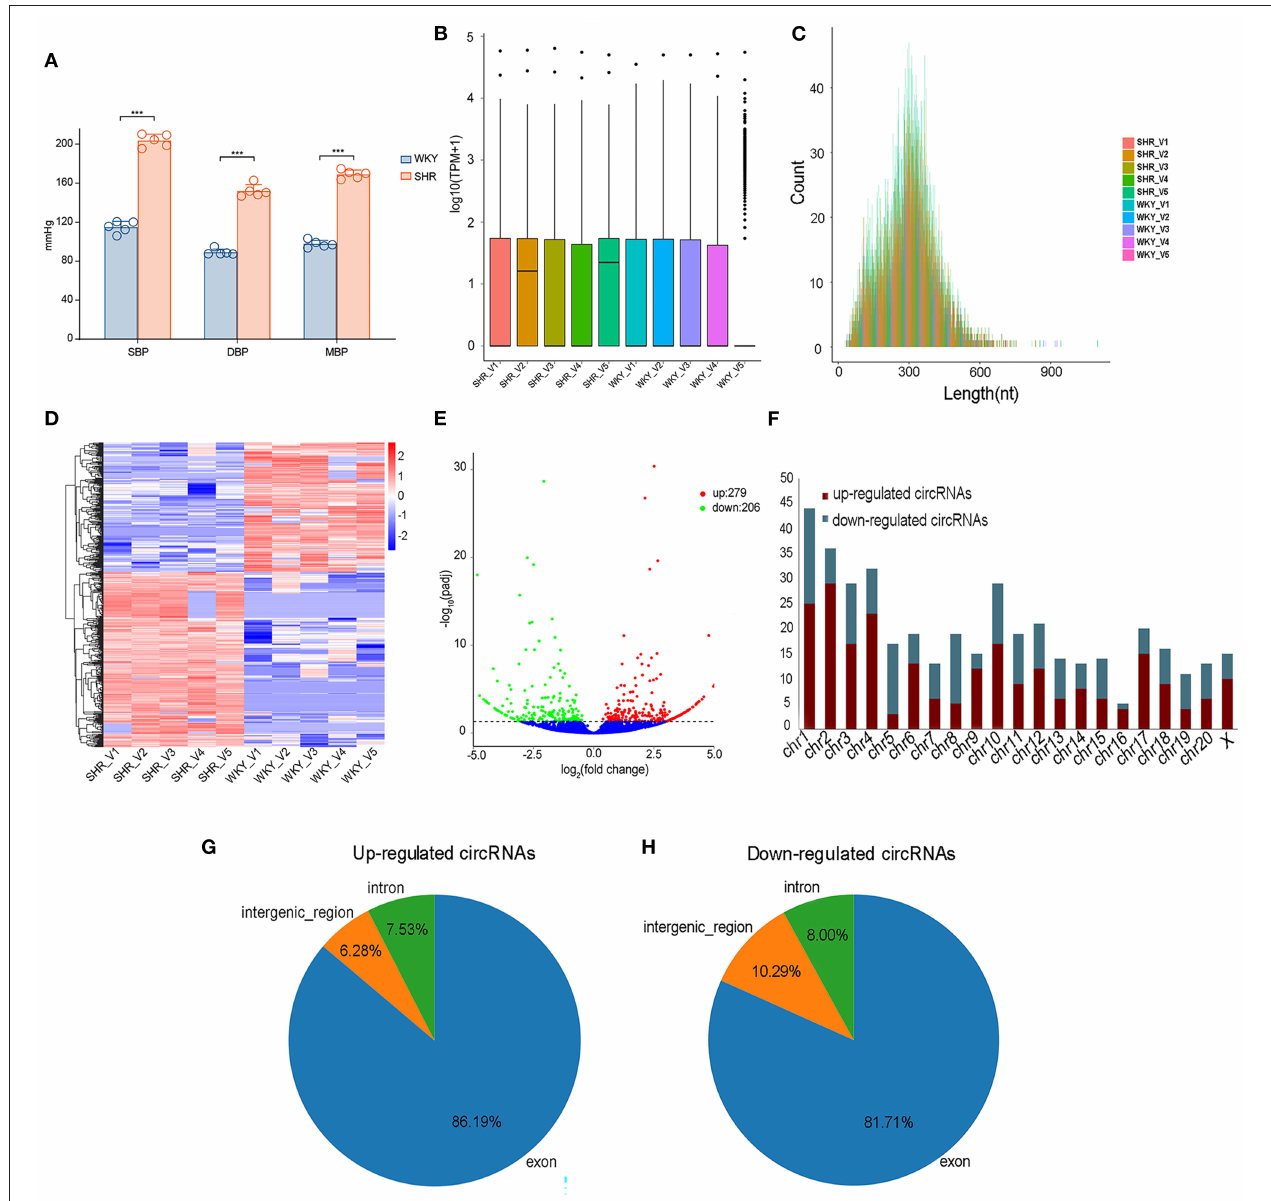
FIGURE 1 | The expression profiling of vascular circRNAs was screened and analyzed by RNA-seq of aortic vascular tissues between SHR and WKY rats. (A) Compared with WKY controls, SBP levels, DBP levels and MBP levels were significantly elevated in SHR rats. (B) The data standardization of the total expression of the circRNAs. (C) The length of circRNA profiles. (D) The hierarchical cluster analysis was performed with the significantly different circRNA expression profiles in SHR and WKY aorta (Fold Change > 2 and P < 0.05); Red and blue denoted high and low relative expression, respectively, each circRNA was expressed by a single row of colored boxes and each sample was represented by a single column. (E) Volcano plot showed that the differential expression analysis of circRNAs (red, up-regulated; green, down-regulated). (F) The distribution of chromosomes of upregulated and downregulated circRNAs, respectively. (G,H) The identification of exon, intron and intergenic region of upregulated and downregulated circRNAs. RNA-seq, high-throughput RNA sequencing; WKY, Wistar-Kyoto; SHR spontaneously hypertensive rat; SBP, systolic blood pressure; DBP, diastolic blood pressure; MBP, mean blood pressure; circRNAs, circular RNAs.